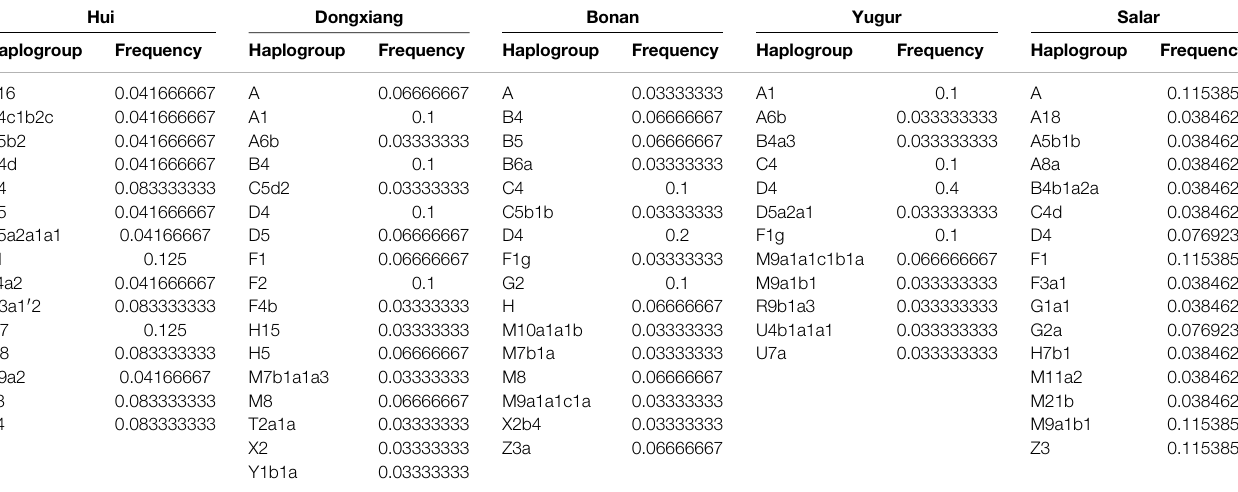
TABLE 4 | The mtDNA haplogroups distribution for our studied populations. Hui